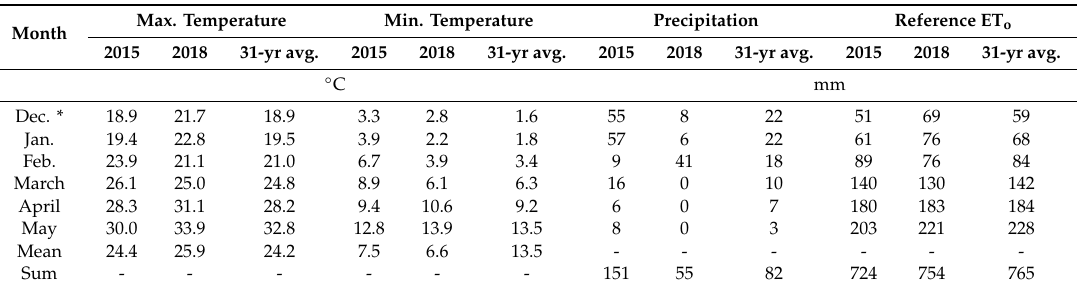
Table 2. Monthly average maximum and minimum temperature, precipitation, and reference ET o for the 2015 and 2018 growing seasons compared with the 31-year average in Tucson, AZ.